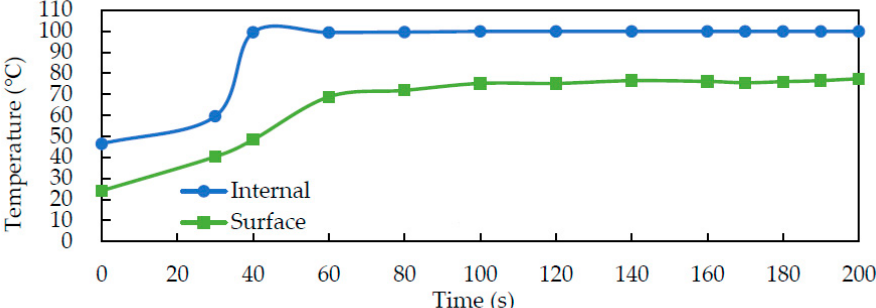
Figure 7. Internal and surface temperature profiles of the solid-state fermented W. cocos products during RF drying with an electrode gap of 15 cm. Data are expressed as mean ± SD ( n = 3).